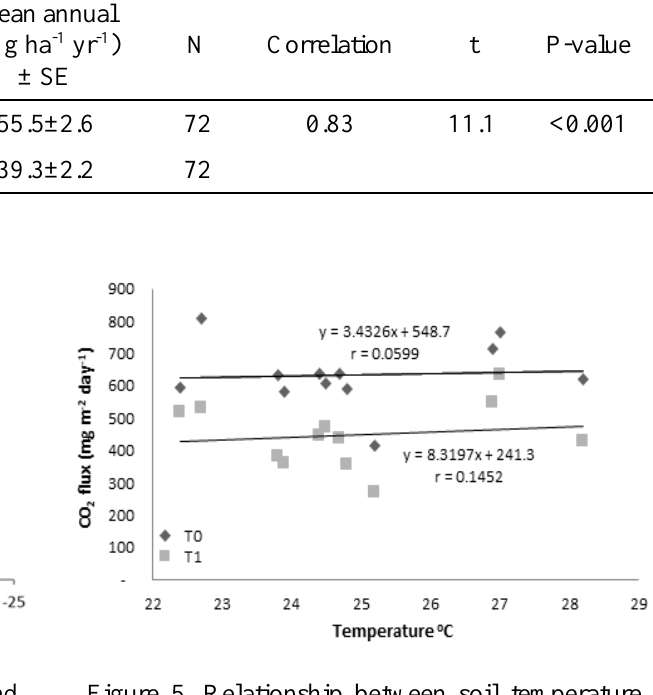
Figure 4. Relationship between water table and carbon dioxide (CO 2 ) flux for the shallow (T0) and deep (T1) collars (r = Pearson correlation).